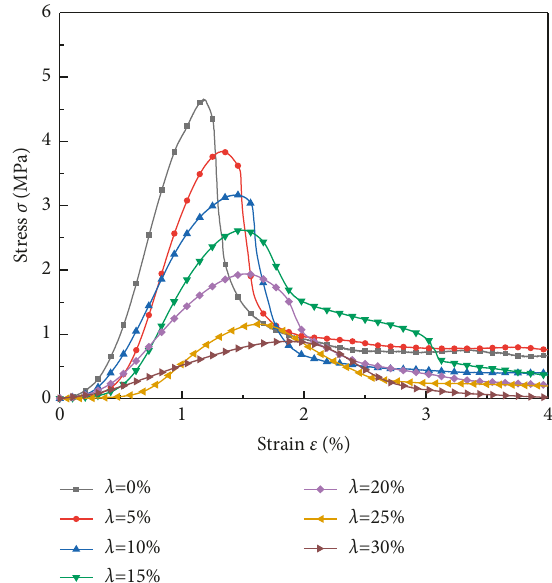
Figure 3: Stress-strain curves of cement-soil and samples UCS with different HA content λ